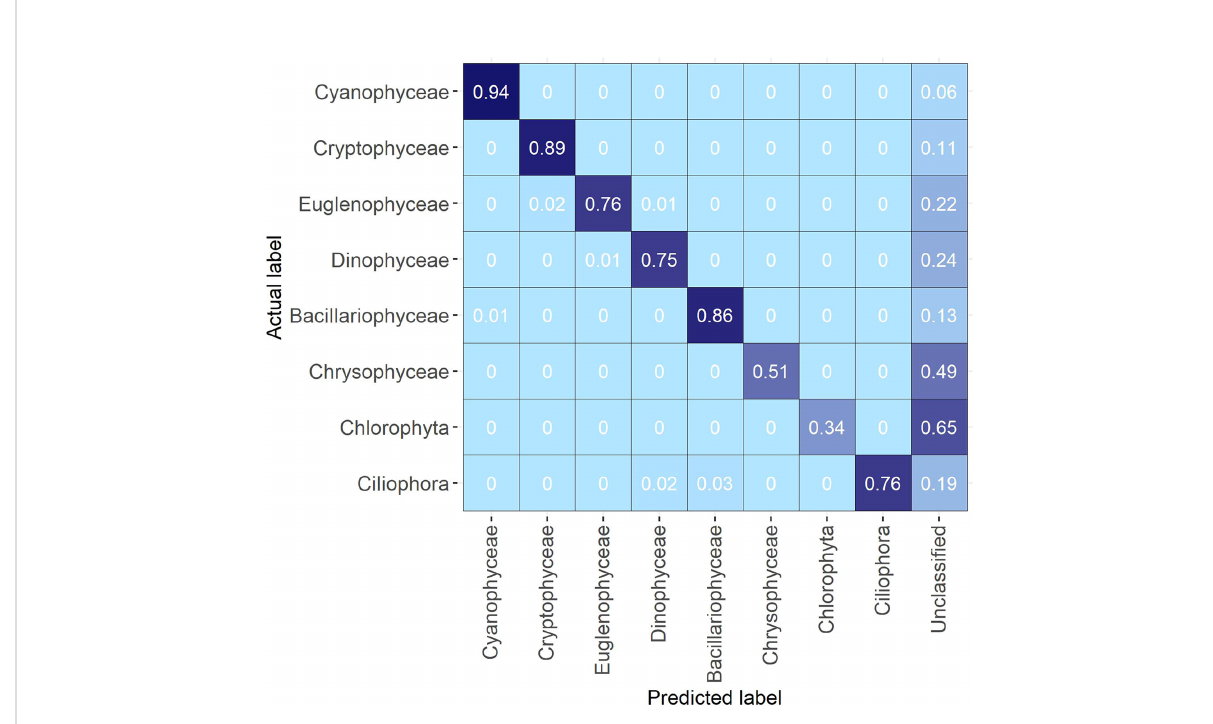
FIGURE 3 Confusion matrix of the Evaluation Data aggregated on broader taxonomic group level.